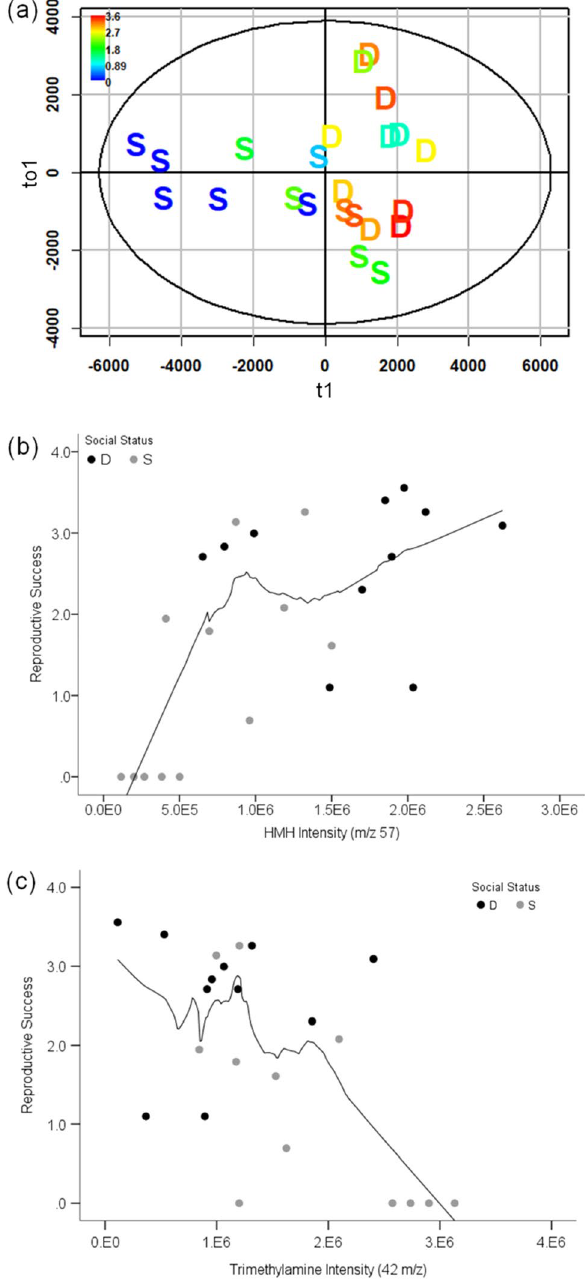
Figure 2. Male reproductive success in relation to VOC expression. OPLS scores plot of reproductive success based on candidate MS-data derived from denatured male urine collected during the enclosure phase ( a ). The x-axis of the scores plot is the predictive component (t1) of the RS response variable. The y-axis is the first orthogonal component (to1). Data points for dominant and subordinates are labeled D and S, respectively. Coloration of the data points indicates the range of RS measured for males; high and low RS range from red to blue, respectively. The Spearman rank correlation of HMH and Trimethylamine expression ( b and c , respectively) with RS shown for intact urine from dominant (black) and subordinate (gray) males during the enclosure phase. The black trend line in the scatterplots shows the loess fit for non-parametric data (50% of data points to fit Epanechnikov